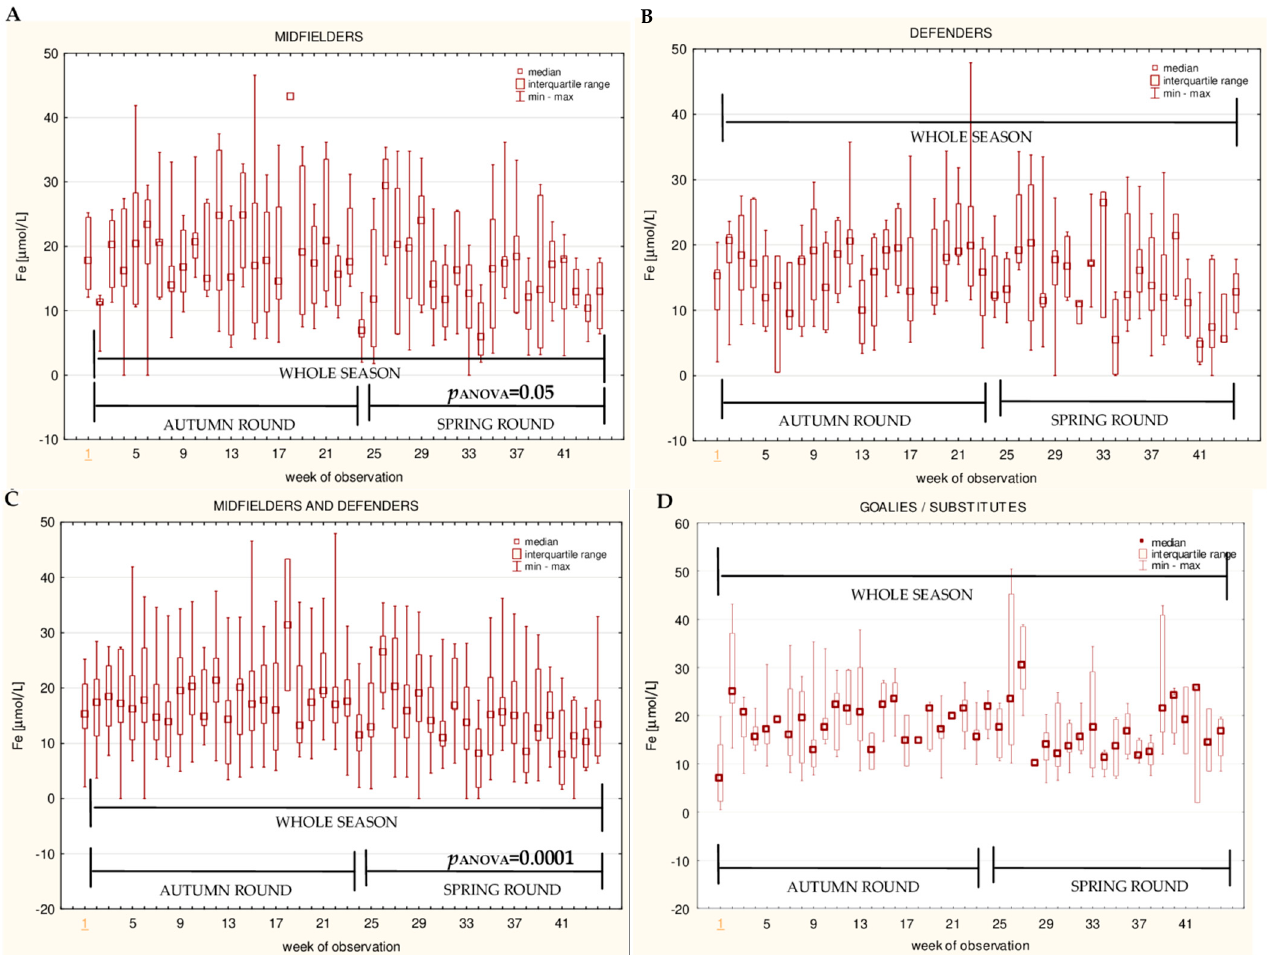
Figure 9. Median iron (Fe) levels in: ( A ) The midfielder, ( B ) defender, ( C ) midfielder / defender and ( D ) goalie / substitute subgroups over the course of the soccer match